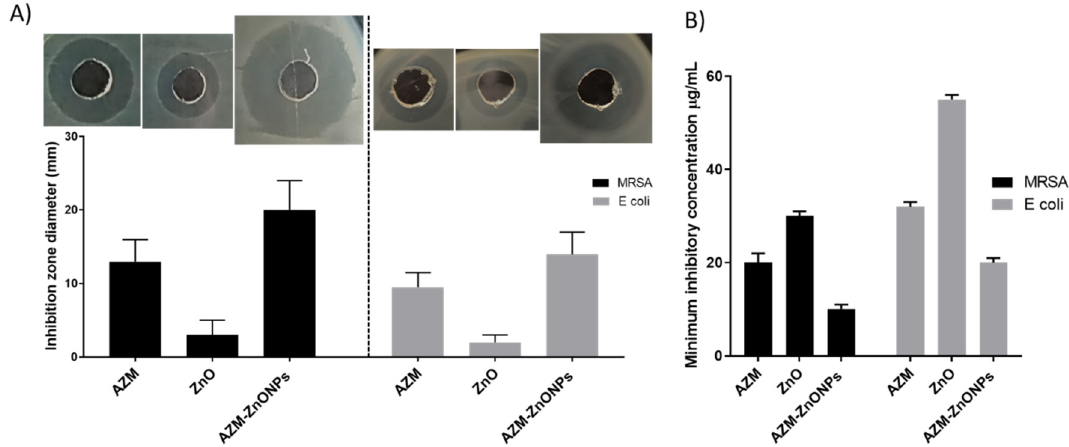
Figure 8. Azithromycin-loaded zinc oxide nanoparticles have superior anti-bacterial activities. ( A ) shows the mean inhibition zone diameters induced by azithromycin (AZM), zinc oxide (ZnO), and azithromycin-loaded zinc oxide nanoparticles (AZM-ZnONPs) in agar plates inoculated by MRSA and E. coli, and a representative figure of each treatment. ( B ) shows the minimum inhibitory concentrations (MIC) of AZM, ZnO, and AZM-loaded ZnONPs against MRSA and E. coli . Data are shown as mean ± standard deviation of 3